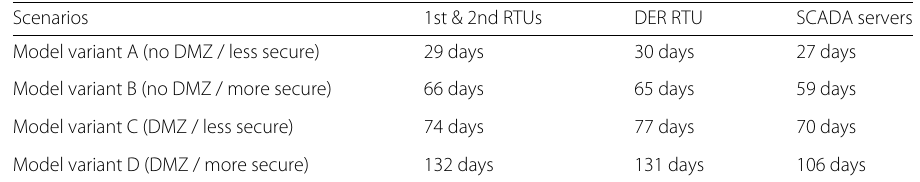
Table 1 Analysis results with an attacker positioned on the Internet Scenarios 1st & 2nd RTUs DER RTU